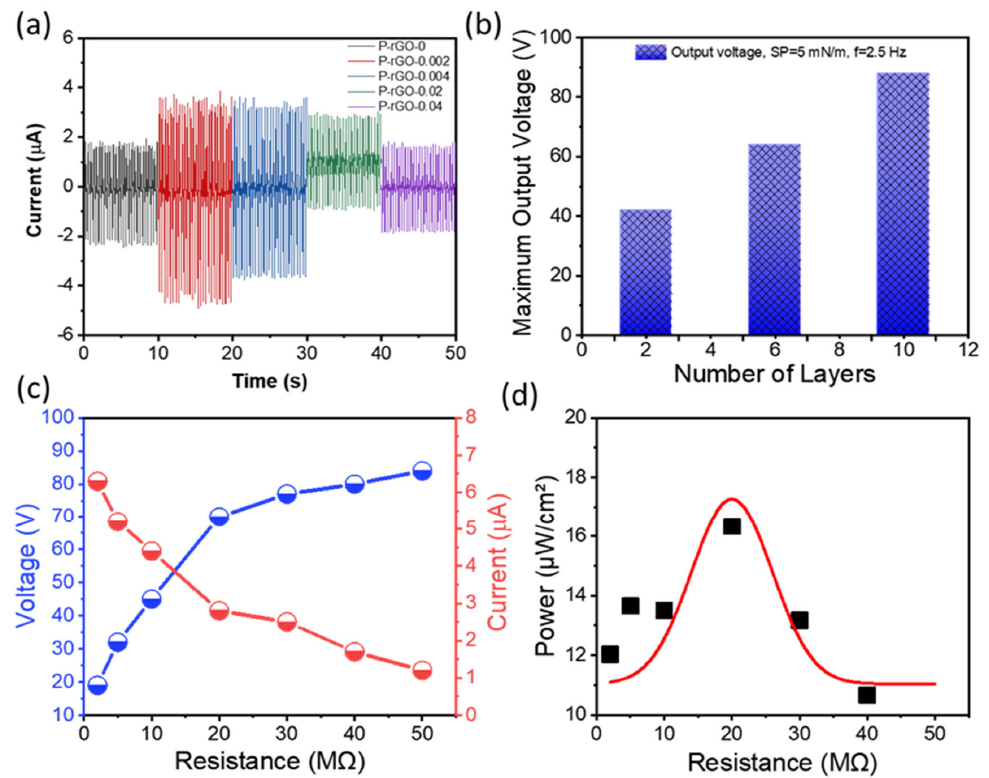
Figure 7. ( a ) I SC of the PENGs with thin films of ten monolayers with different rGO contents at π = 5 mN/m and 2.5 Hz; ( b ) peak ‐ peak V OC for the PENGs with thin films of different number of monolayers with 0.002 wt% rGO at π = 5 mN/m and 2.5 Hz; ( c ) resistance dependencies of voltage and current; ( d ) resistance dependency of power density for the optimum PENG.